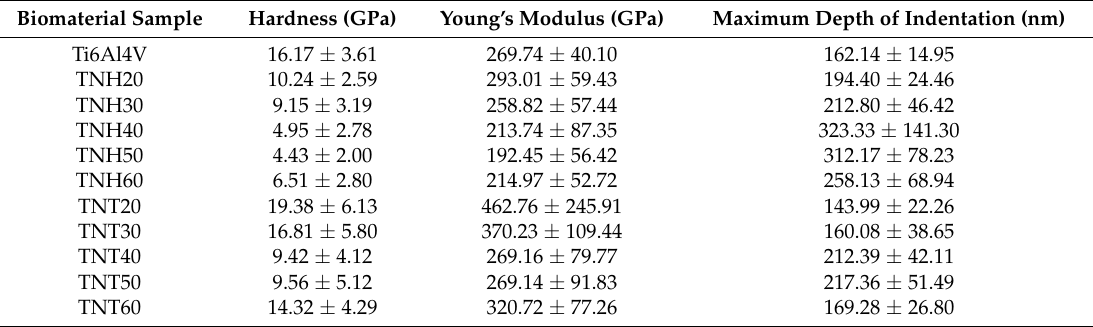
Table 1. Mechanical and nanoindentation properties (hardness, Young’s modulus and maximum